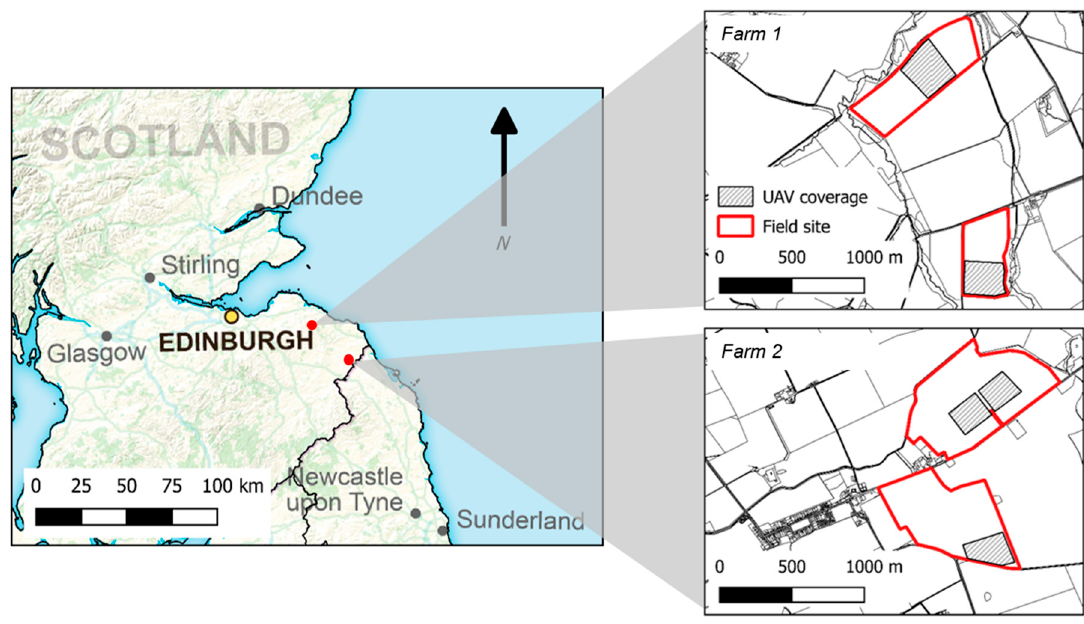
Figure 1. Locations of two farms (red dots) and map insets highlighting the field sites (red border) and within-field areas of interest (black cross-hatching) where field campaign data, including ground measurement and UAV surveys, were carried out.